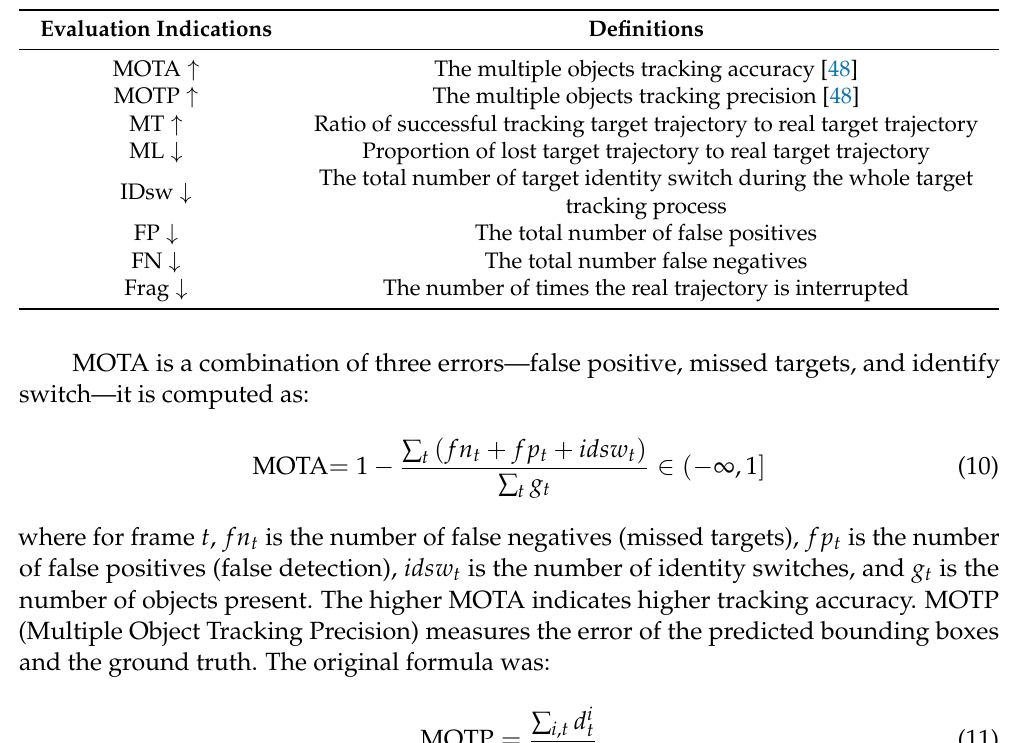
Table 3. MOT evaluation indications and definitions. “ ↑ ”: higher scores denote better performance, “ ↓ ”: lower scores denote better performance.